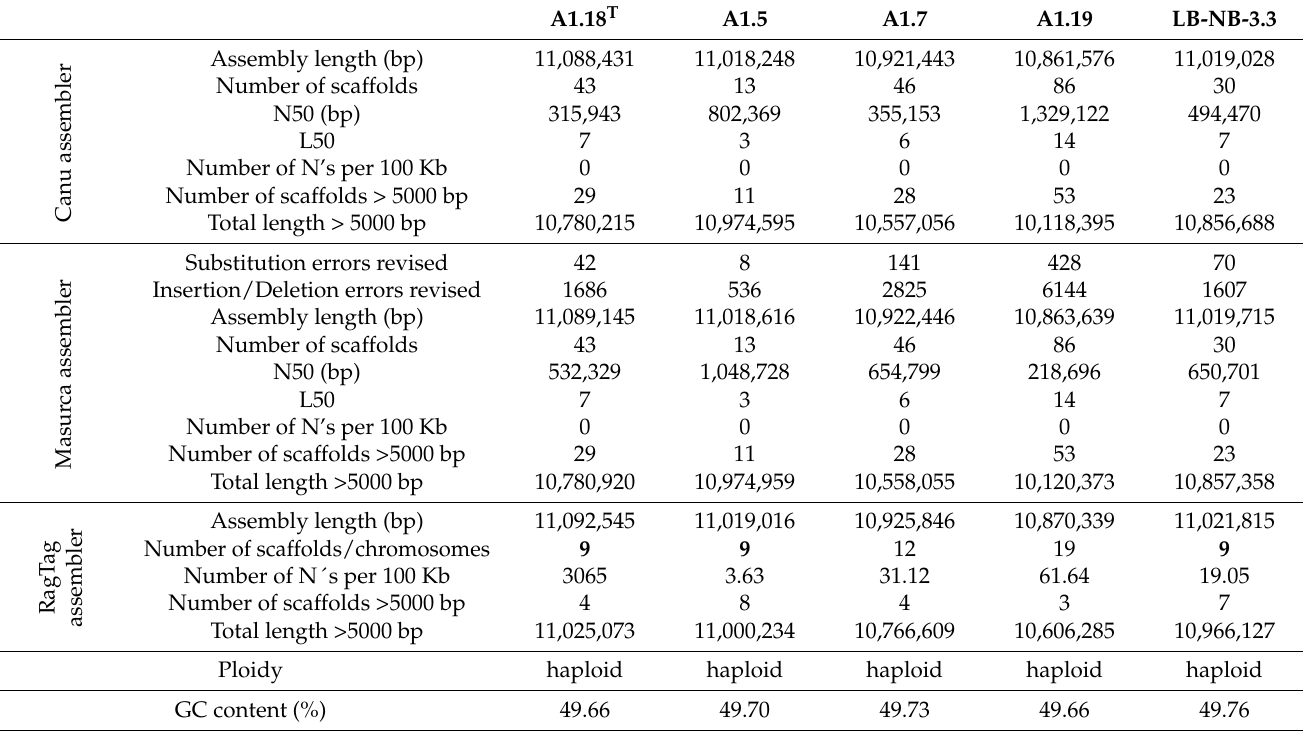
Table 1. Genome assembly statistics of Clavispora santaluciae